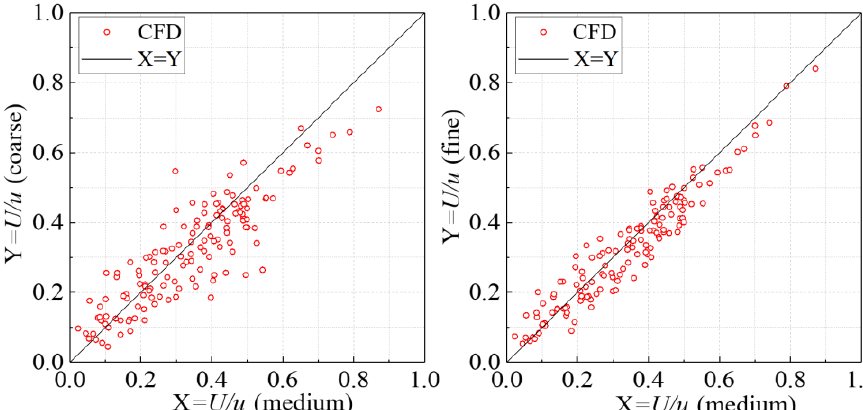
Figure 5. Grid independence study.